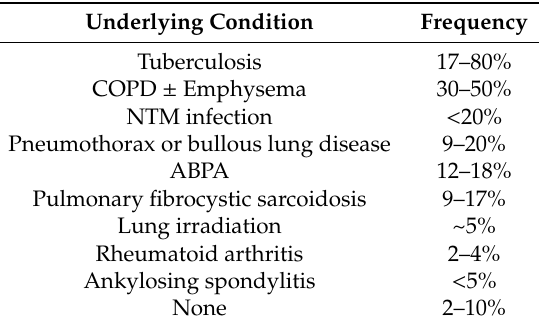
Table 2. Underlying conditions in chronic pulmonary aspergillosis.